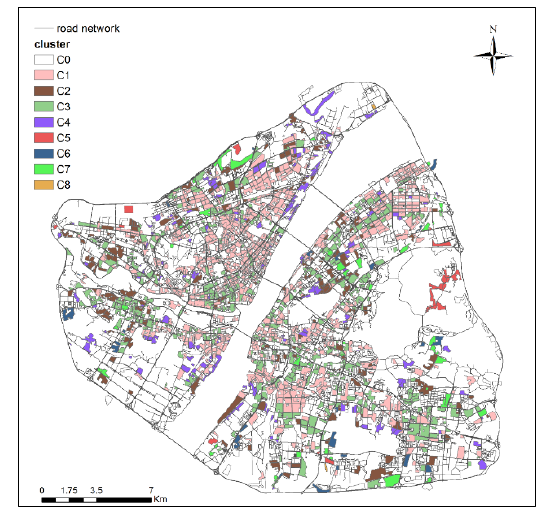
Figure 7. The geographical distribution of eight clusters of residential